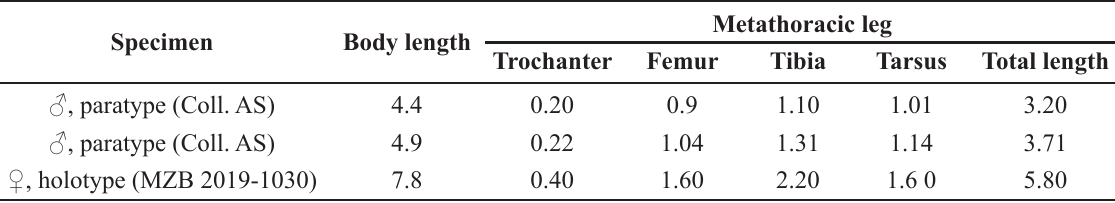
Table 3. Plusiocampa ( Plusiocampa ) chiosensis Sendra & Gasparo sp. nov. Length of the body, metathoracic legs and their segments: trochanter, femur, tibia and tarsus (measurements in mm). Specimen Body